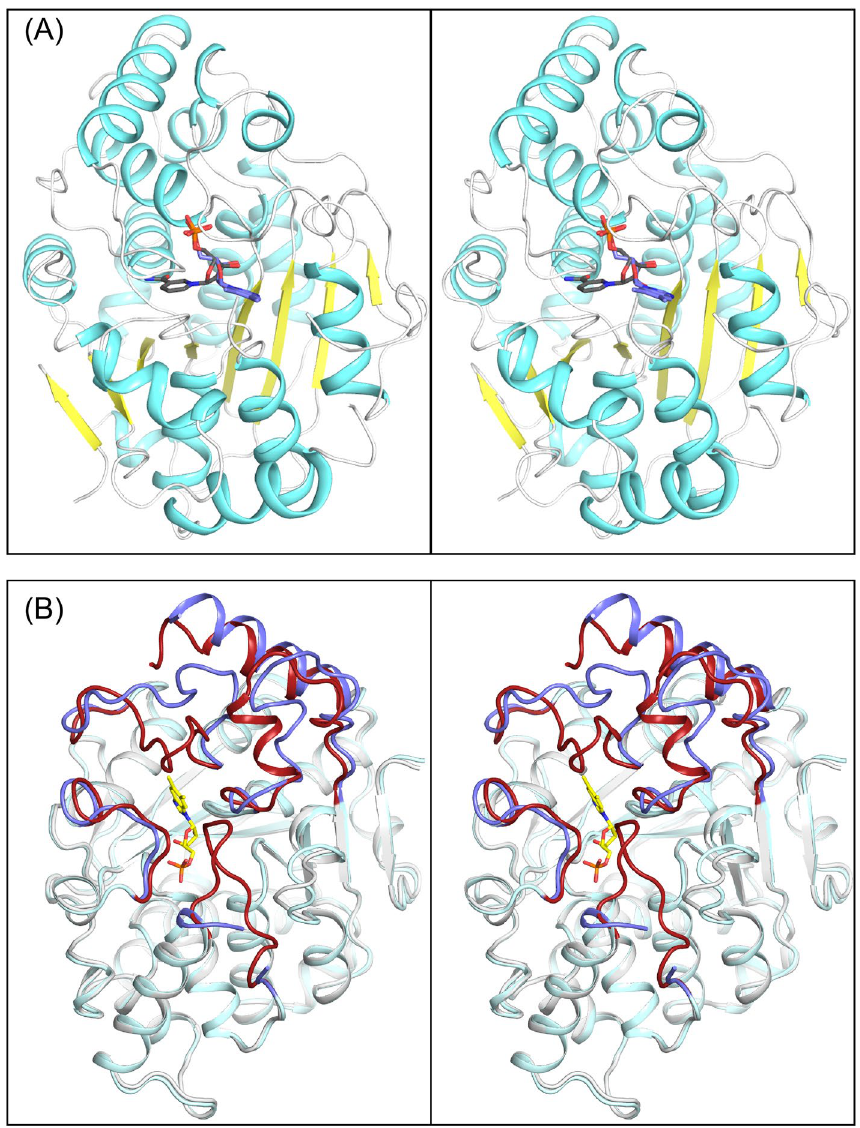
Figure 4. Stereo view of the location of the active site in Mj CobT and the conformational changes that occur on ligand binding. ( A ) shows a superposition of NaMN and α-RP from crystalline complex of substrate and products and reveals the entirety of the active site located at the C-terminal ends of the β-sheet. ( B ) shows a comparison between the apo-structure and subunit B that contains α-RP. The loops that show significant change between the apo Mj CobT and the complex with α-RP and nicotinic acid are depicted in blue and dark red respectively. This reveals that the active site is open to solvent in the apo structure, but is enclosed when product is bound. These changes in tertiary structure are associated primarily with those regions of the protein that constitute the binding site for the nitrogenous